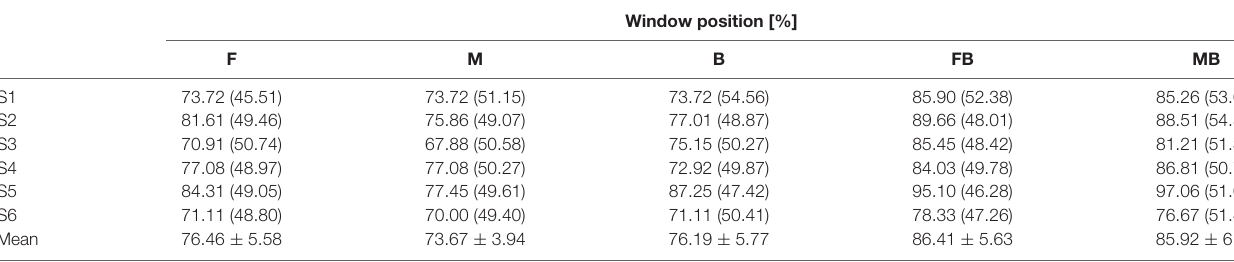
TABLE 1 | Classification accuracies for left vs. right.